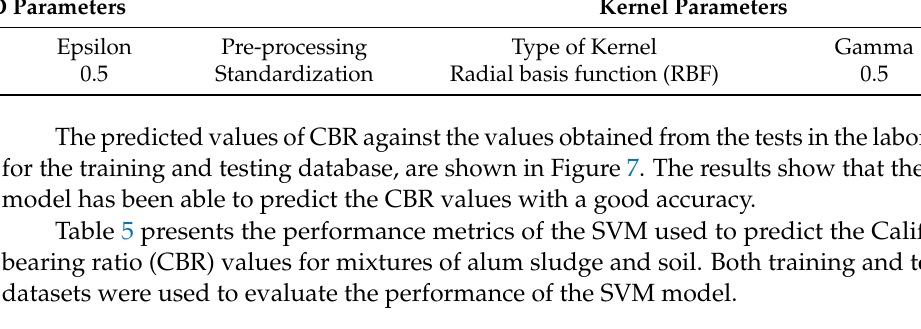
Table 5. Results of SVM predictions of CBR for mixtures of alum sludge and